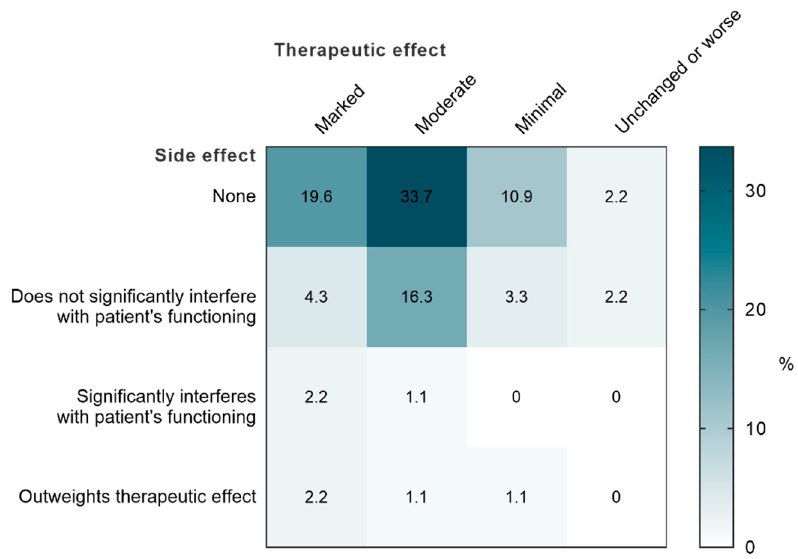
Figure 6. Clinical Global Impression—Efficacy Index.